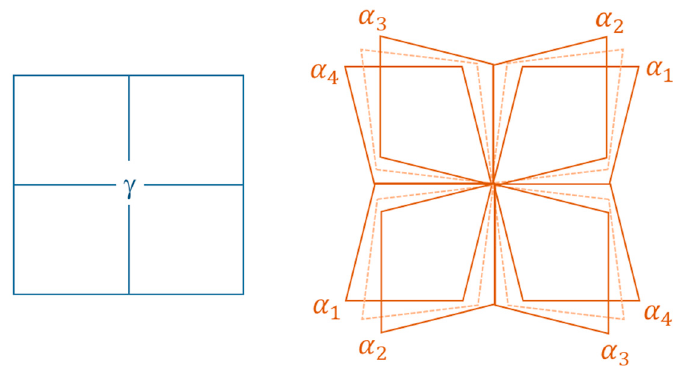
Figure 20. Global compatibility between the variants mediated by the closing-gap ORs and the associated orientation gradients.